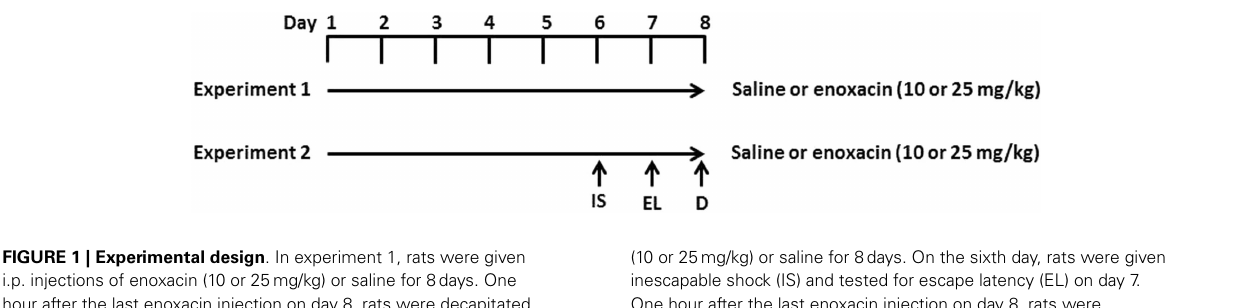
FIGURE 1 | Experimental design . In experiment 1, rats were given i.p. injections of enoxacin (10 or 25mg/kg) or saline for 8days. One hour after the last enoxacin injection on day 8, rats were decapitated (D). In experiment 2, rats were given i.p. injections of enoxacin